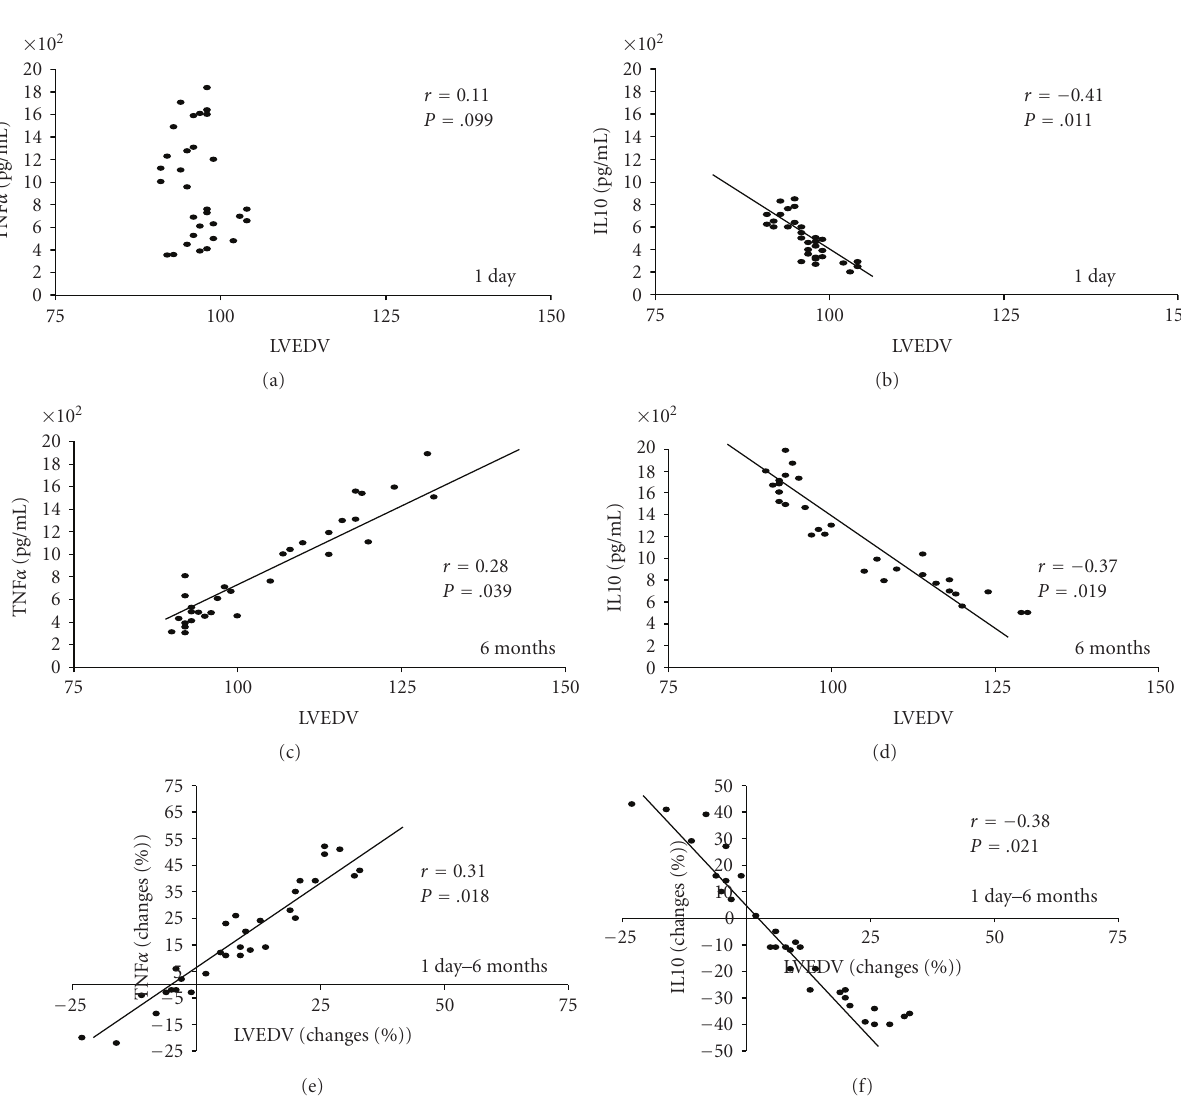
Figure 7: Linear regression coe ffi cient (Spearman’s) between TNF α , IL10, and Echocardiographic Left Ventricular end-diastolic volume (LVEDV) in the whole cohort ( n = 40) at day 1, 6 months, and trend day 1–6 months. Each data is provided as continuous variable (day 1 and 6 months) and percent changes (trend day 1–6